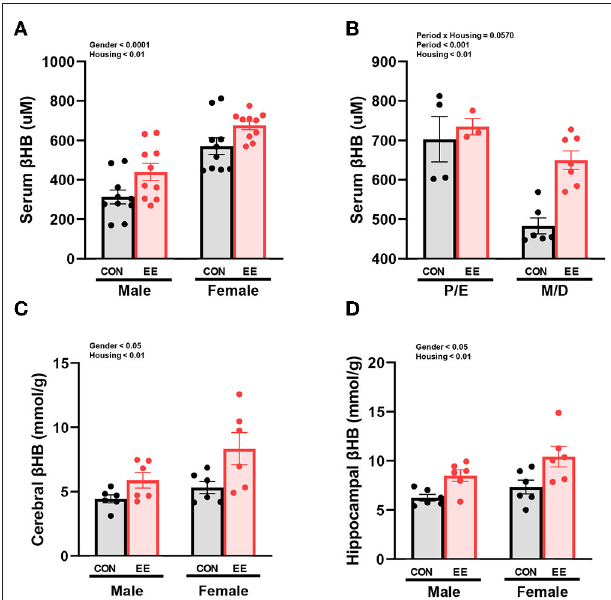
FIGURE 2 | Differential β HB level by sex and exposure to EE in normal models. β HB enzyme-linked immunosorbent assay (ELISA) was conducted in serum ( n = 10 per group), cerebral cortex ( n = 6 per group), and hippocampus ( n = 6 per group). (A) Serum β HB levels. (B) Further female subgroup analysis based on estrus cycle in serum β HB. (C) Cerebral cortex β HB and (D) Hippocampus β HB. Two-way ANOVA with Tukey multiple comparison test. Significant sex effect, significant housing effect, and the significant interaction between sex and housing were noted with p -value. Data are means ±